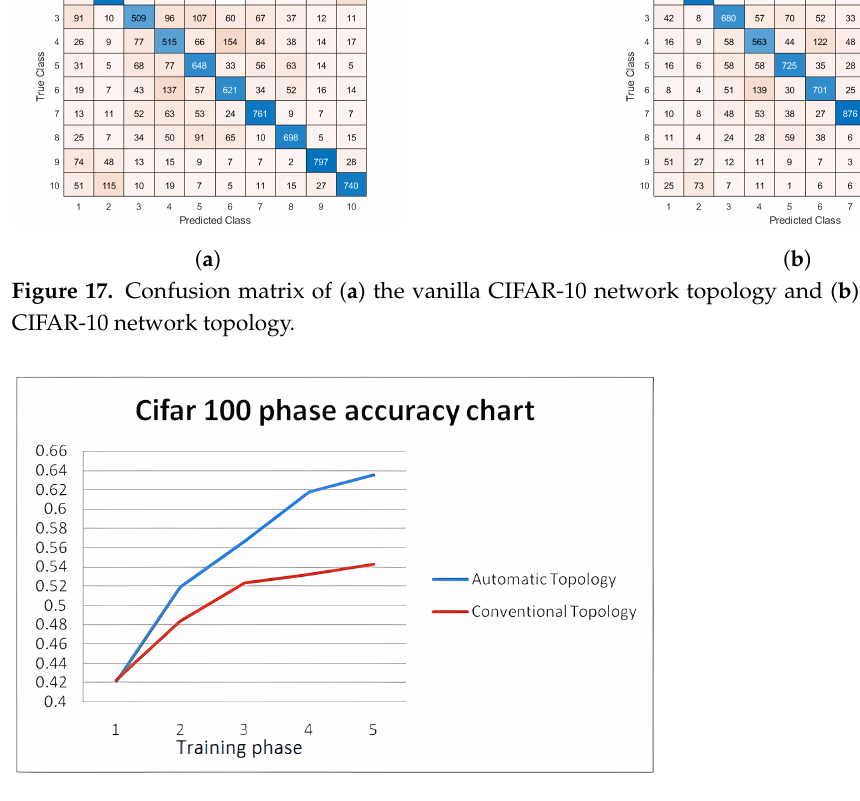
Figure 18. Testing accuracy convergence of the vanilla CIFAR-100 network topology and the adaptive CIFAR-100 network